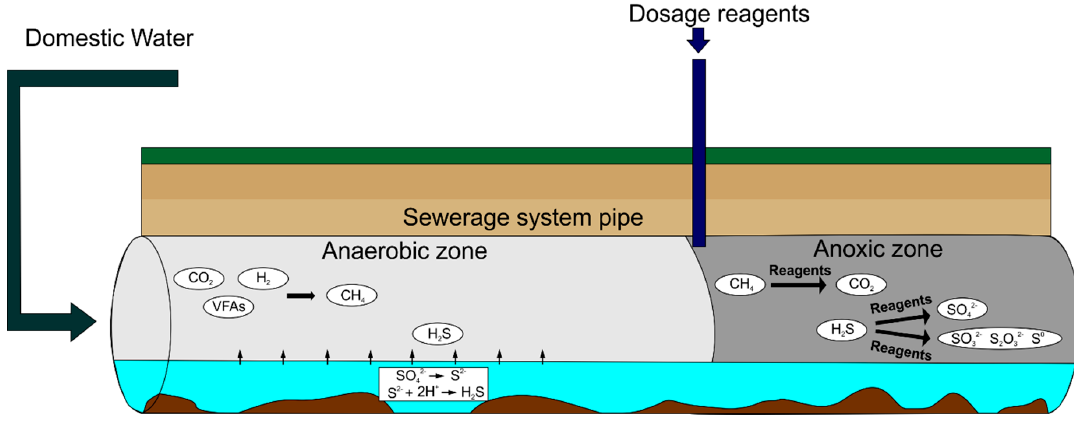
Figure 4. An example of reagents being dosed into sewer systems.